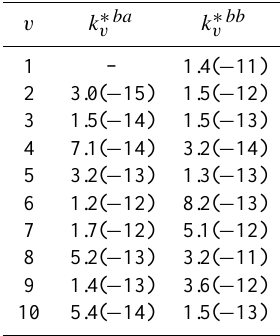
Table 6. Applied rate coefficients in Eq. (9).